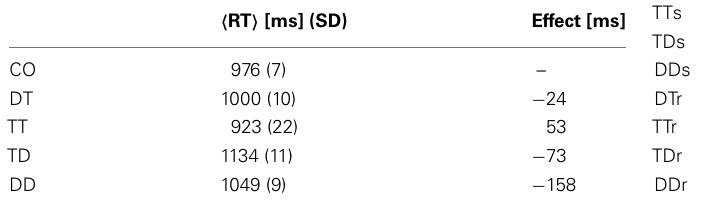
Table 5 | Mean reaction time and effect strength for the priming conditions CO, DT,TT produced by the GMNP in episodic-retrieval mode as described in Section 3.2.